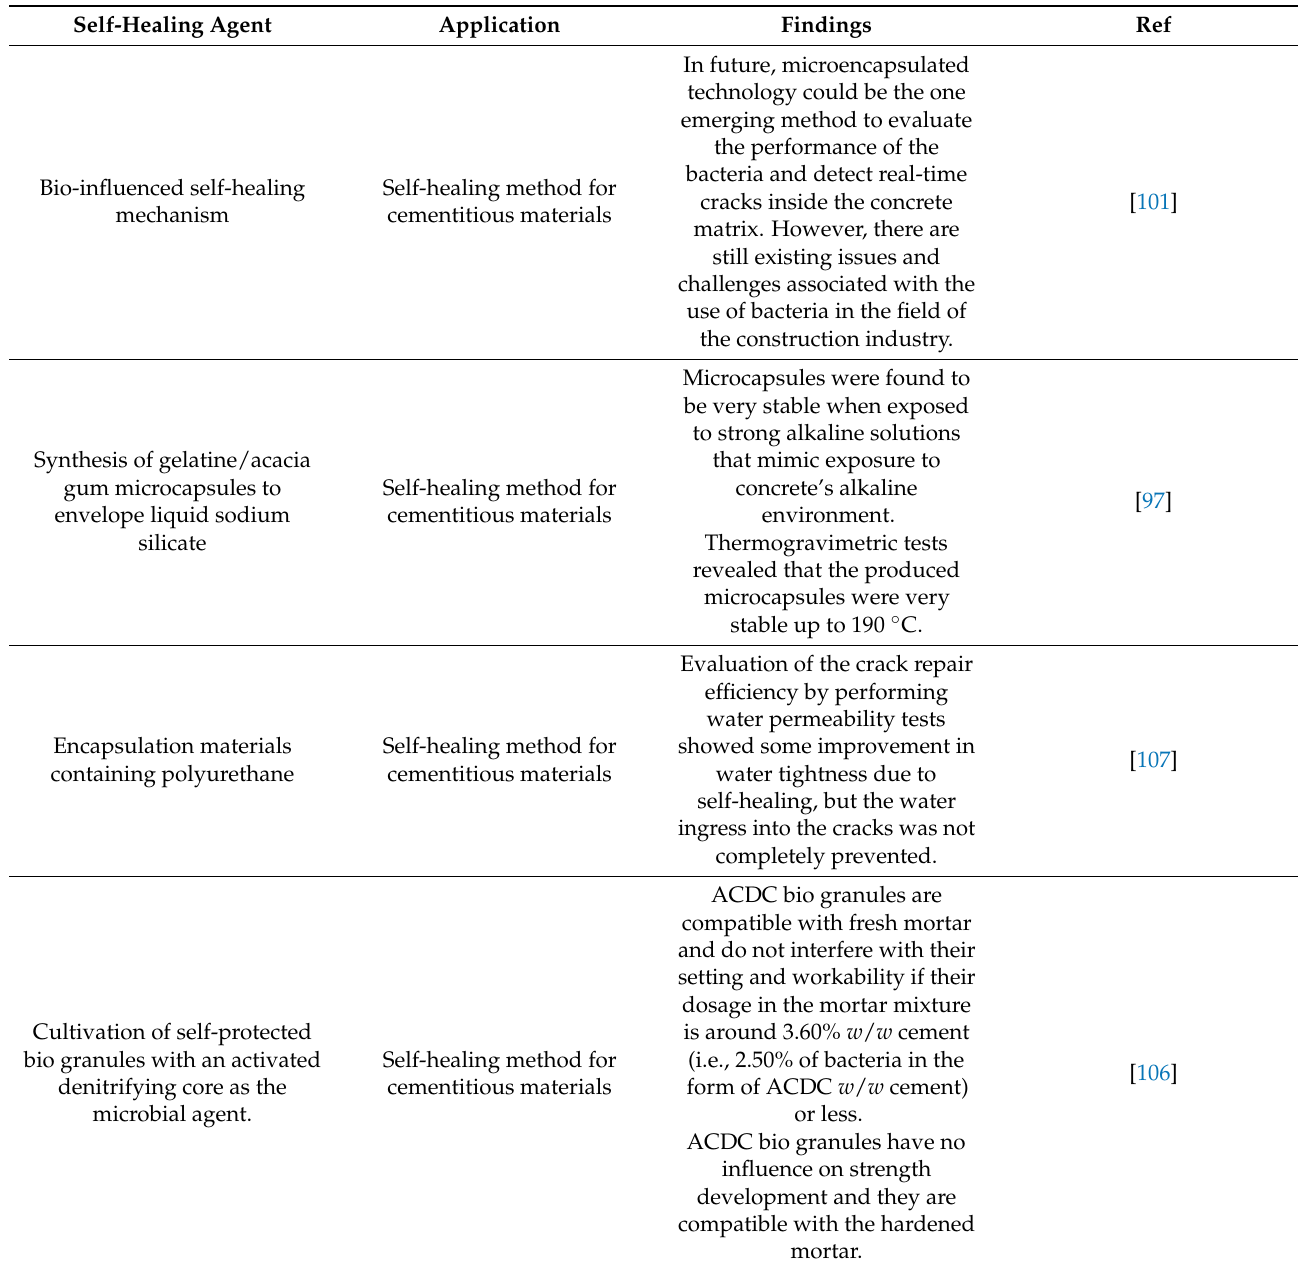
Table 5. Cont . Self-Healing